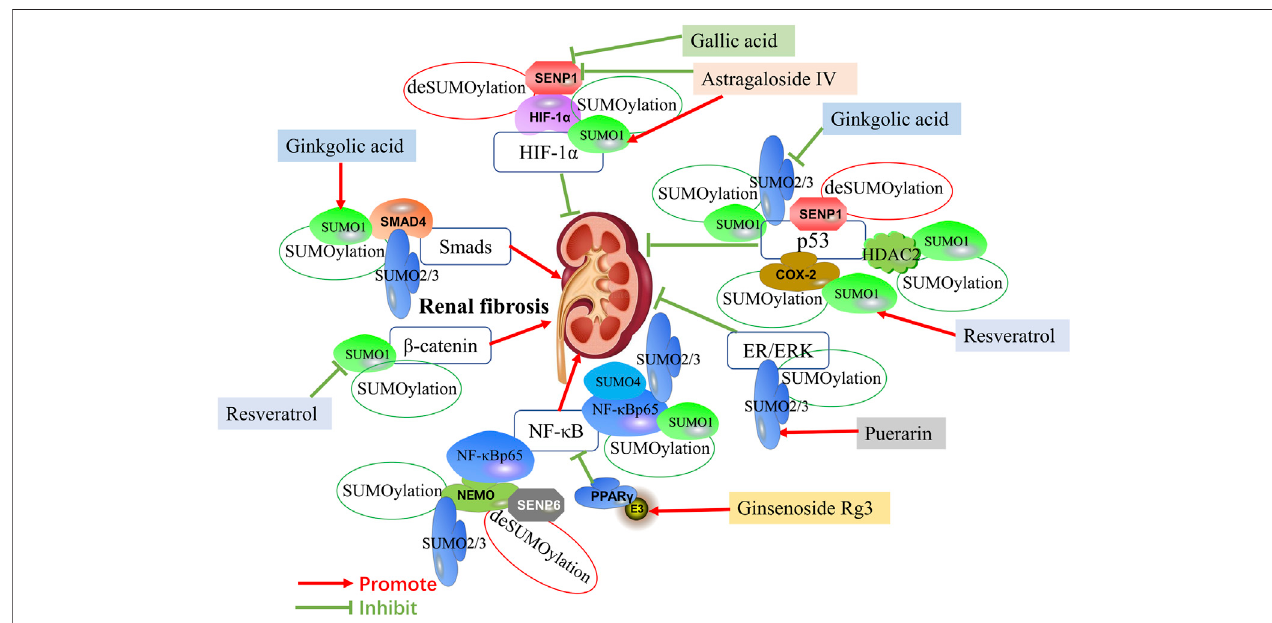
FIGURE 1 | Mechanisms of SUMOylation and deSUMOylation by transcription factors in renal fi brosis and therapeutic targets of natural products against renal fi brosis via SUMOylation. Mechanisms of SUMOylation and deSUMOylation by transcription factors in renal fi brosis are including TGF- β /Smad signaling, HIF-1 α signaling, p53 pathway, ER/ERK pathway, NF- κ B signaling, and β -catenin pathway. Smad4 is SUMOylated by SUMO1 and SUMO2/3. HIF-1 α is SUMOylated by SUMO1. P53 is SUMOylated by SUMO1 and SUMO2/3, and also is upregulate by HDAC2 and COX-2 SUMOylated by SUMO1. ER/ERK is SUMOylated by SUMO2/3. NF- κ Bp65 is SUMOylated by SUMO1, SUMO2/3 and SUMO4, and also is upregulate by NEMO SUMOylated by SUMO2/3. PPAR γ activated by SUMO ligase E3 could inhibit NF- κ B signaling. β -catenin is SUMOylated by SUMO1. SNEP1 deSUMOylates HIF-1 α and p53. Additionally, SNEP6 deSUMOylates NEMO. Ginkgolic acid promotes the expression of Smad4 by upregulating SUMO1, while inhibits the expression of p53 by downregulating SUMO2/3. Astragaloside IV promotestheexpressionofHIF-1 α byupregulating SUMO1anddownregulatingSENP1.GallicacidalsopromotestheexpressionofHIF-1 α bydownregulatingSENP1. Resveratrol induces SUMOylated COX-2 by SUMO1, thus enhancing the expression of p53. In addition, Resveratrol inhibits the expression of β -catenin by downregulating SUMO1. Puerarin activates ER/ERK pathway by upregulating SUMO2/3. Ginsenoside Rg3 inhibits NF- κ B by upregulating PPAR γ via activating